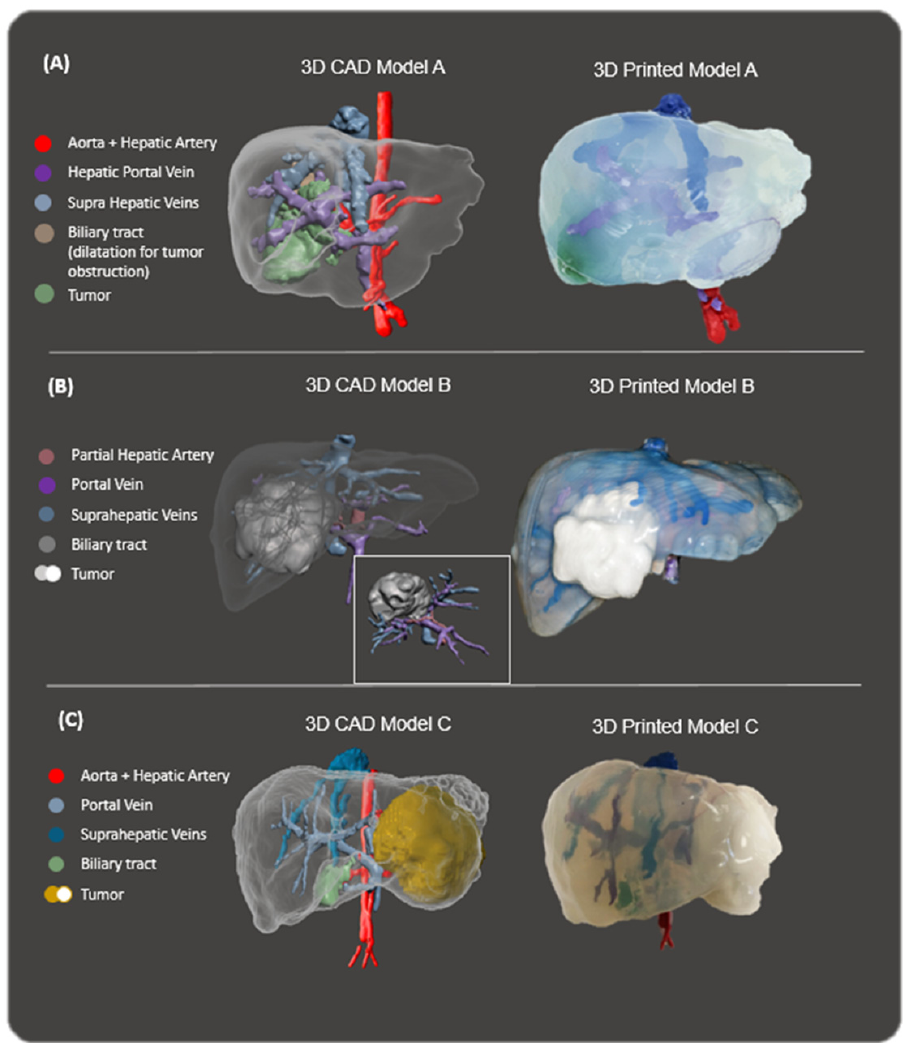
Figure 3. 3D models in CAD file and manufactured final model of the different cases: ( A ) Case #1. ( B ) Case #2. ( C ) Case #3.